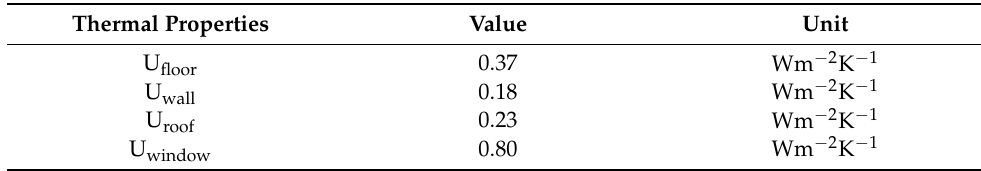
Table 4. Thermal properties of the single-family building.